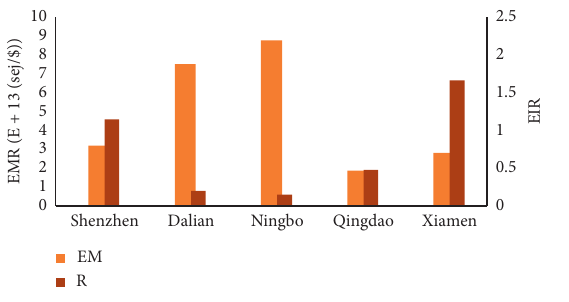
Figure 4: EMR and EIR of each city in 2017.